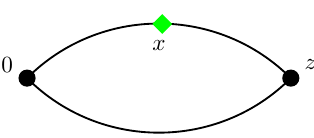
Figure 4 . Quark-connected diagram for the strong isospin correction to a mesonic two-point function. The green diamond vertex denotes the insertion of the scalar current